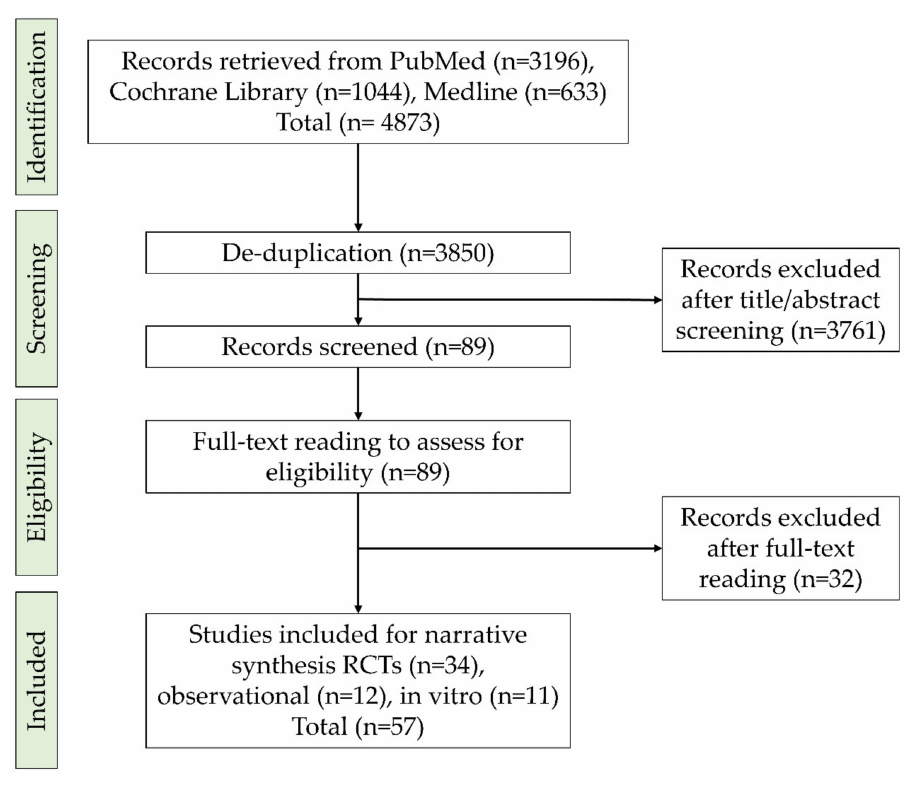
Figure 1. Flowchart of the study